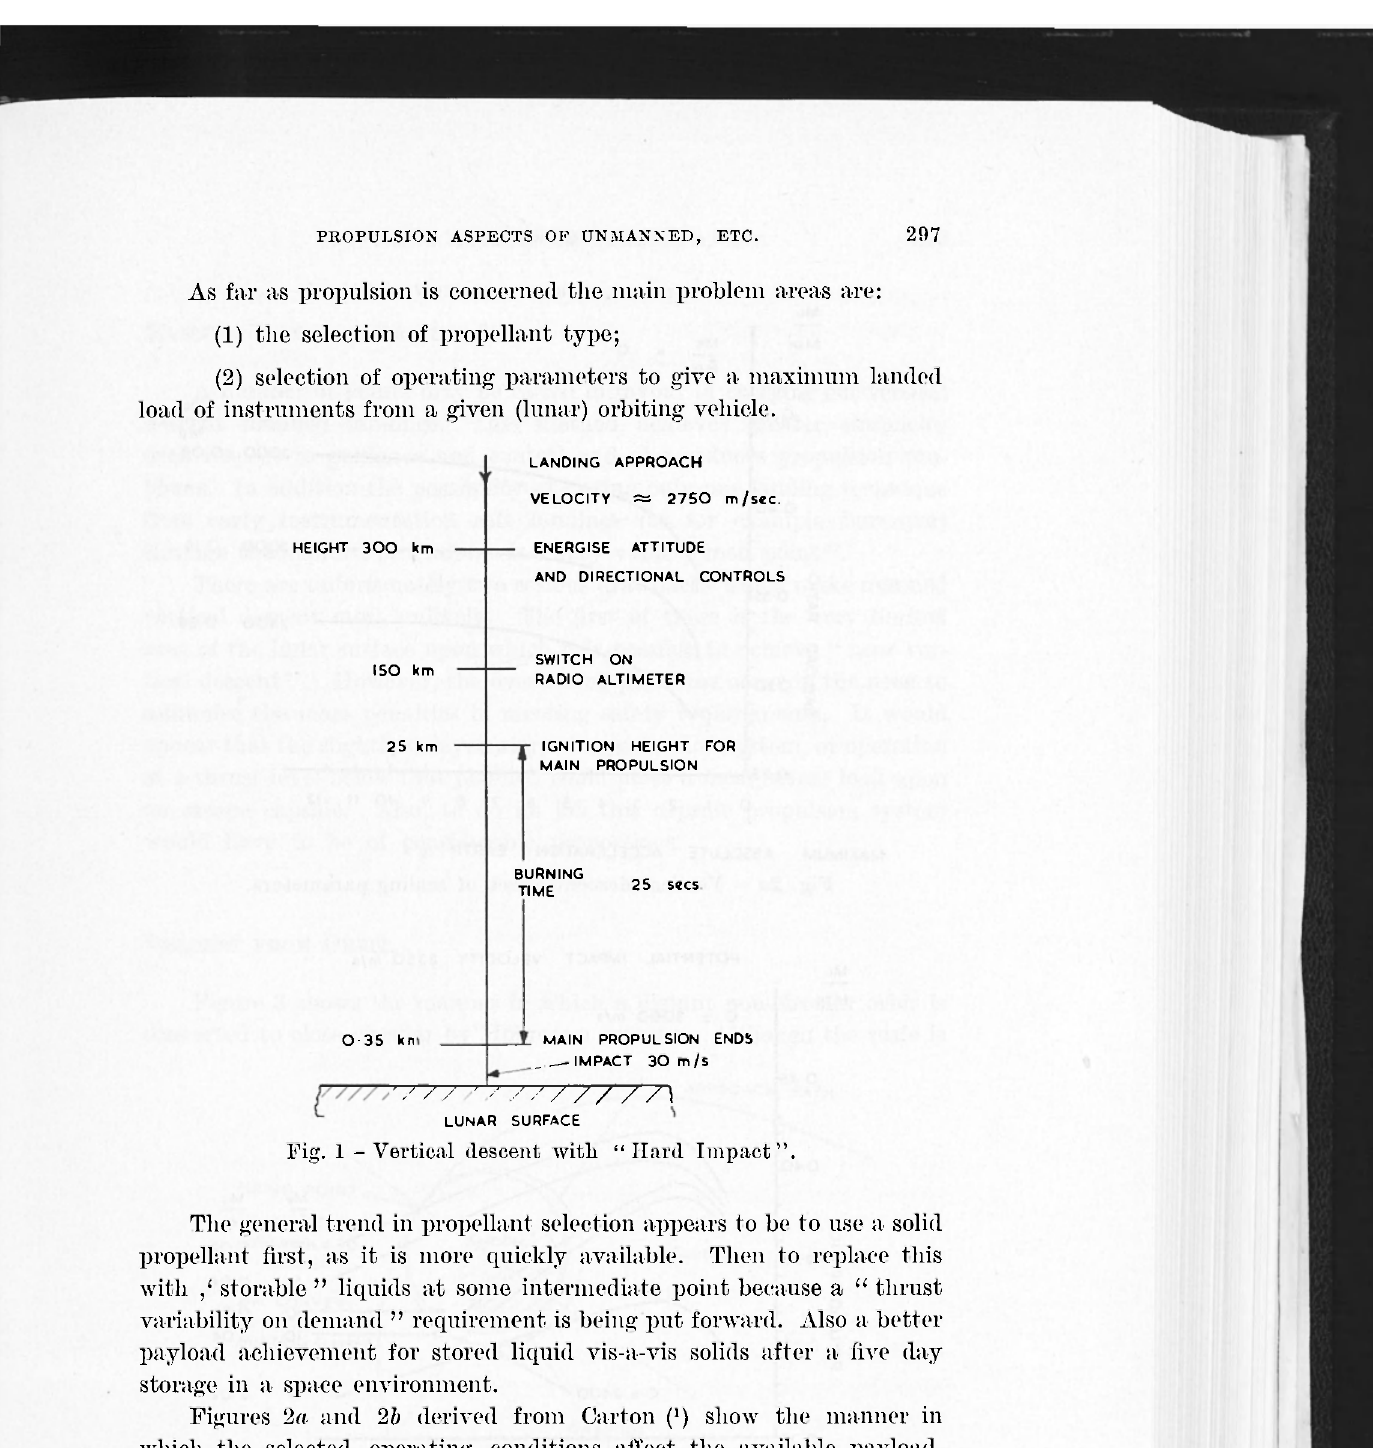
Fig. 1 - Yertioal descent with "Hard